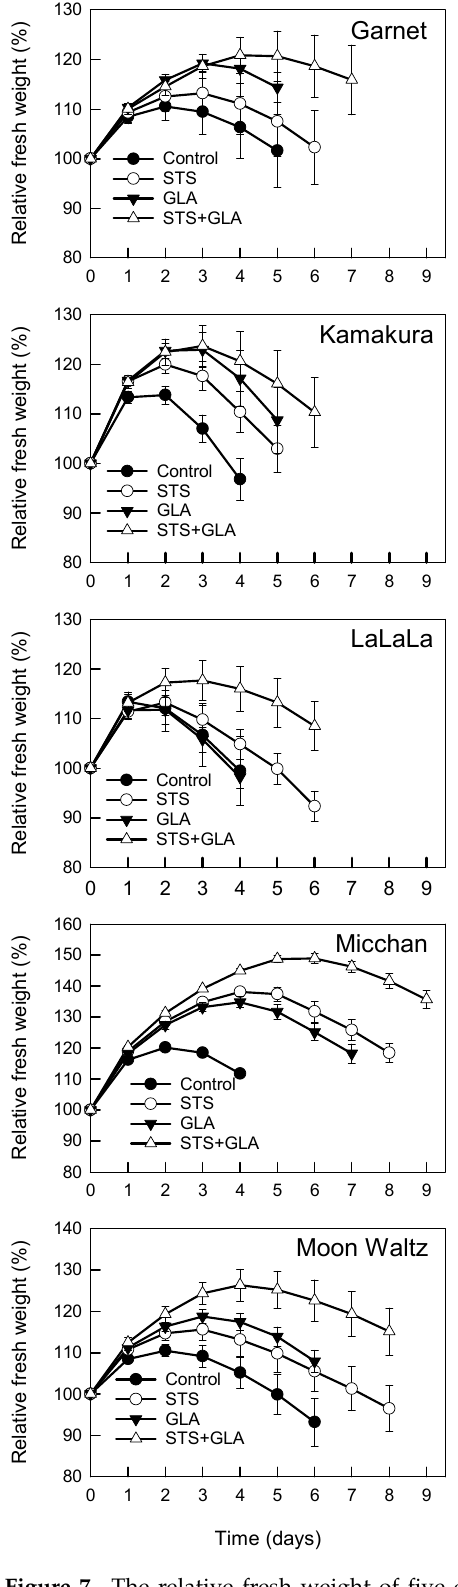
Figure 7. The relative fresh weight of five dahlia cultivars pulse-treated with STS followed by continuous treatment with GLA. Values are the means of five replicates ± SE.